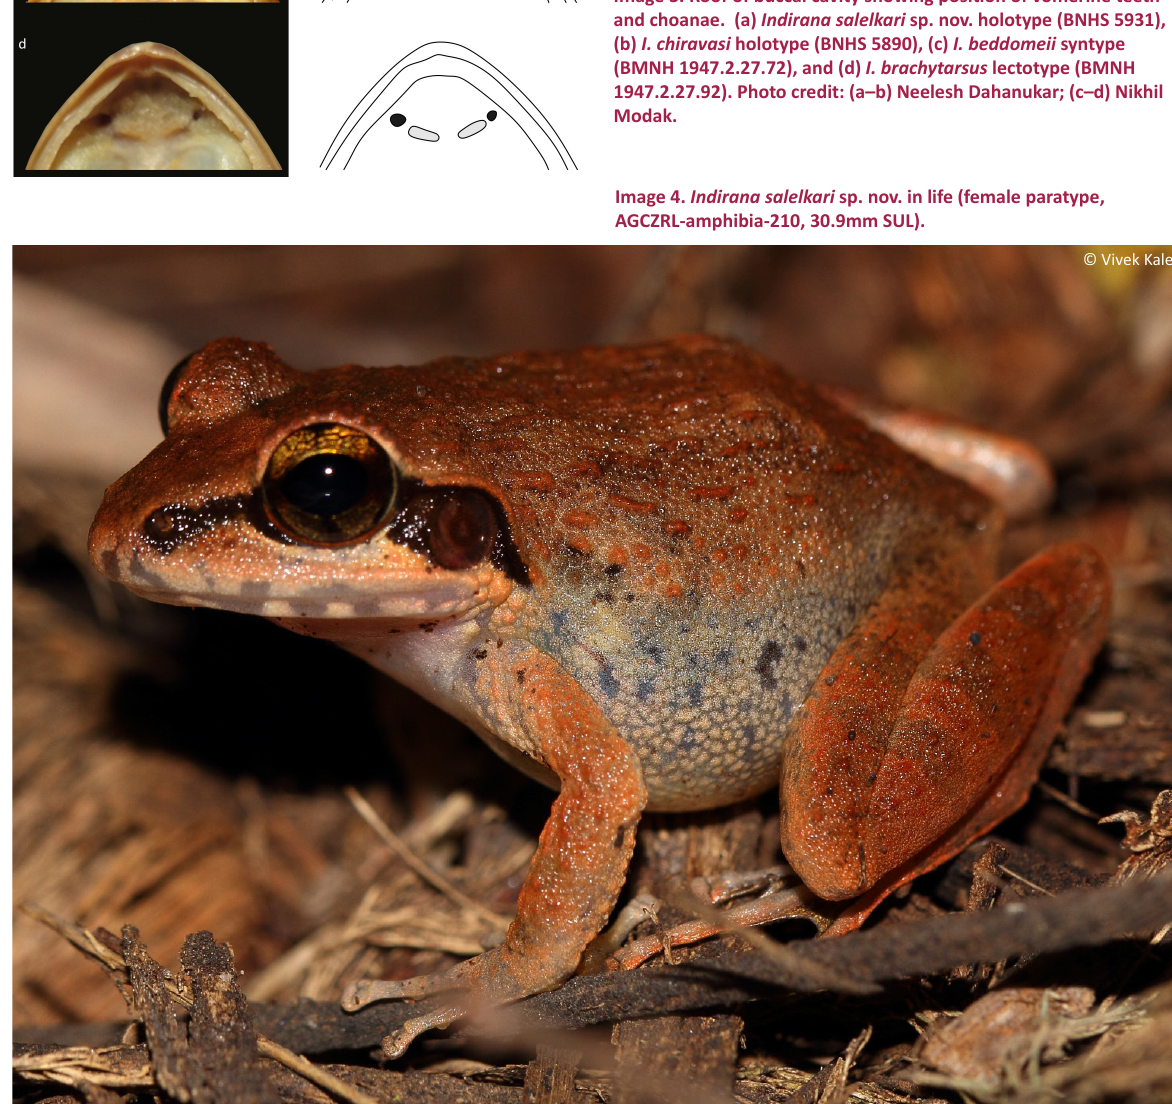
Image 3. Roof of buccal cavity showing position of vomerine teeth and choanae. (a) Indirana salelkari sp. nov. holotype (BNHS 5931), (b) I. chiravasi holotype (BNHS 5890), (c) I. beddomeii syntype (BMNH 1947.2.27.72), and (d) I. brachytarsus lectotype (BMNH 1947.2.27.92). Photo credit: (a–b) Neelesh Dahanukar; (c–d) Nikhil Modak.